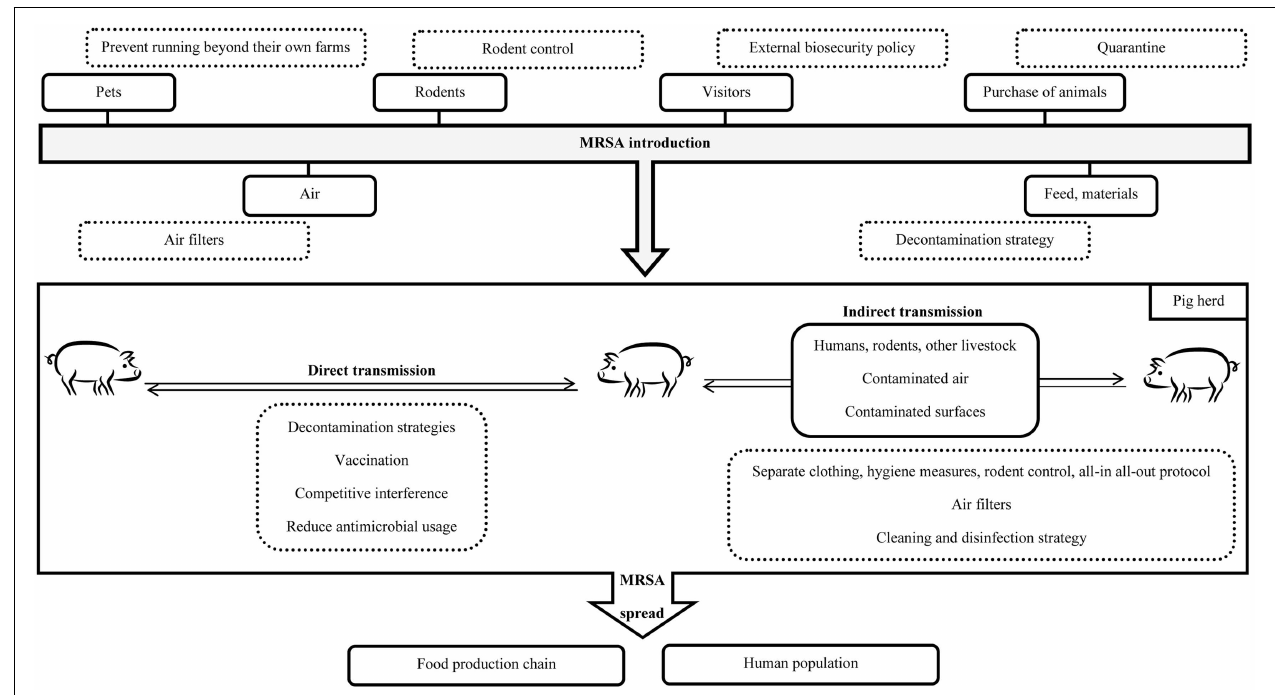
FIGURE 2 | Schematic representation of possible MRSA transmission routes (black line) and theoretical intervention strategies (pointed gray).